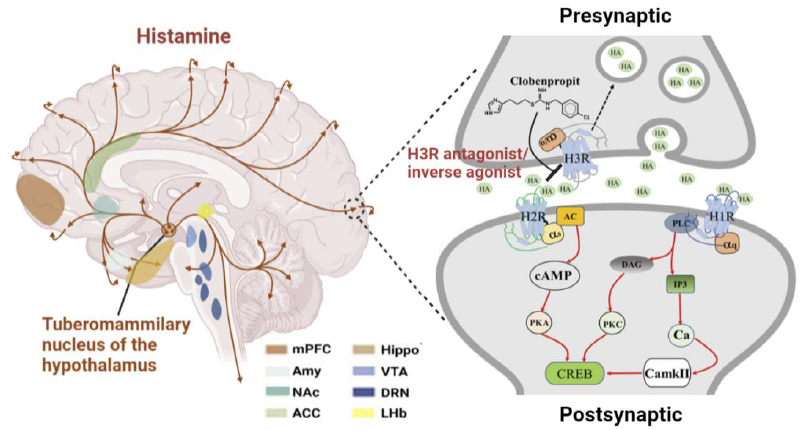
Figure 1. Schematic diagram illustrating the working mechanism of the H3R antagonist/reverse agonist in depression. HA is primarily derived from histaminergic neurons located solely in the tuberomammillary nucleus in the posterior hypothalamus and which project axons throughout the brain including critical brain regions associated with depression. Presynaptic inhibitory H3R regulates HA secretion by negative feedback (dotted black line). H3R antagonists/reverse agonists, such as Clobenpropit, exhibit an antidepressant effect by inhibiting H3R and thus increasing HA release (solid black line). Postsynaptic H1R and H2R modulate intracellular signaling pathways (solid red line). Abbreviations: HA, histamine.